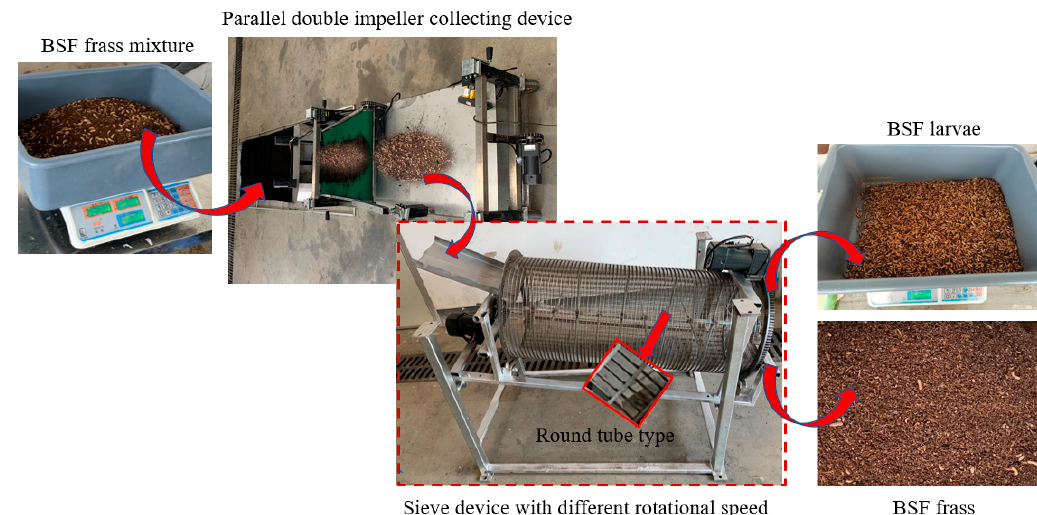
Figure 11. Test platform for the BSF frass mixture.